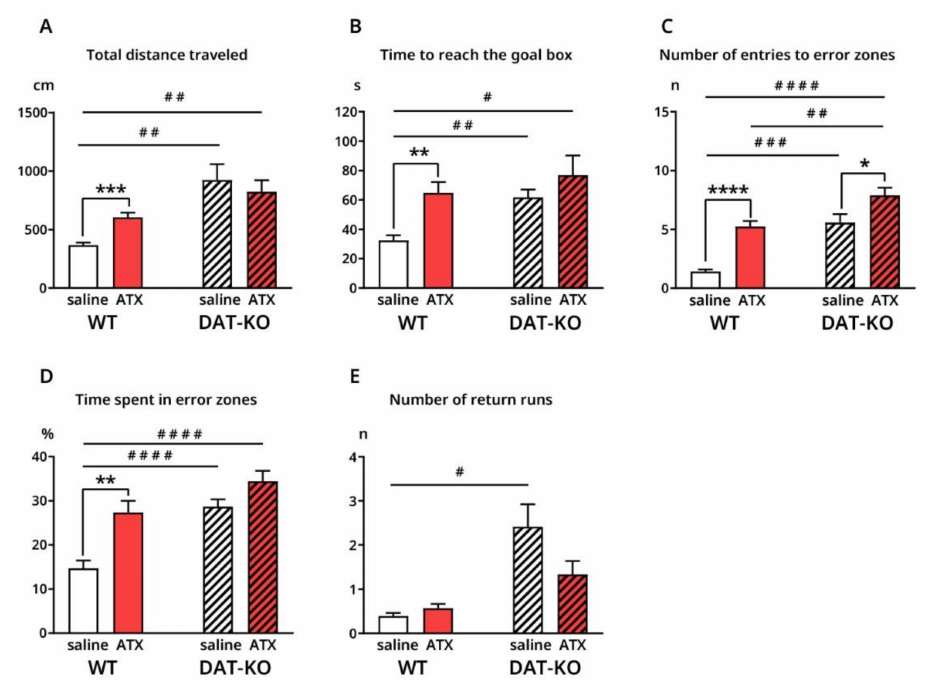
Figure 2. Behavioral characteristics of DAT-KO and WT rats after saline and ATX injections in Hebb–Williams maze ( A – E ). *, # p < 0.05; **, ## p < 0.01; ***, ### p < 0.001; ****, #### p < 0.0001; Brown–Forsythe and Welch ANOVA, Holm–Sidak’s multiple comparisons test. ATX injections majorly affected wild type animals. Total distance (604.7 ± 39.9 cm vs. 367.1 ± 21.6 cm; p = 0.0005) and time to reach the goal box (64.9 ± 7.3 s vs. 32.5 ± 3.5 s; p = 0.0045) significantly increased under ATX, compared to saline injections (Figure 2A,B). ATX had a similar effect on the number of visits (5.2 ± 0.5 vs. 1.4 ± 0.2; p < 0.0001) and percentage time spent in error zones (27.4 ± 2.6 vs. 14.7 ± 1.8; p = 0.003) (Figure 2C,D).